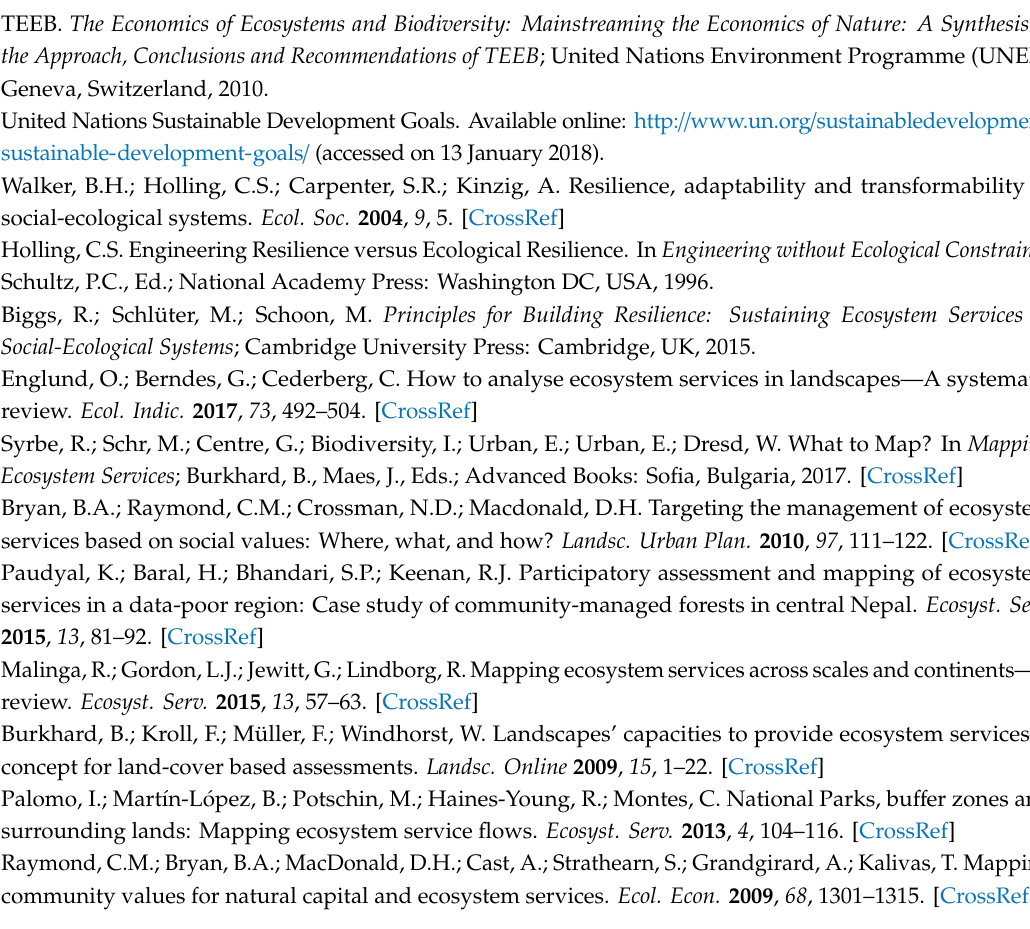
Table S1. Ecosystem services found in the Nyangatom woreda, based on literature, prior research, and transect walks within the region, to be annotated during focus groups. Figure S1. Digitized participatory map showing provisioning ecosystem services related to grazing, compiled from all six focus groups. Figure S2. Digitized participatory map showing provisioning ecosystem services related to natural products (i.e., other than agriculture and grazing), compiled from all six focus groups. Figure S3. Digitized participatory map showing cultural ecosystem services, compiled from all six focus groups. Table S2. Land cover categories and description. Figure S4. Photographs of representative Land Cover types. A & B—Water in the river; C—Bare; D—Forest; E & F—Wetland (Photographs taken from the same location, E—in the wet season, F—in the dry season); G & H—Grassland; I & J—Shrubland. Table S3. Error Matrix for 2016–2019 Classified Land Cover. Table S4. Error Matrix for 2001–2003 Classified Land Cover. Table S5. ES listed by each focus group during the mapping activity (K = Kopriay, A = Ayepa, N = Napasmuria, W = Women, M =